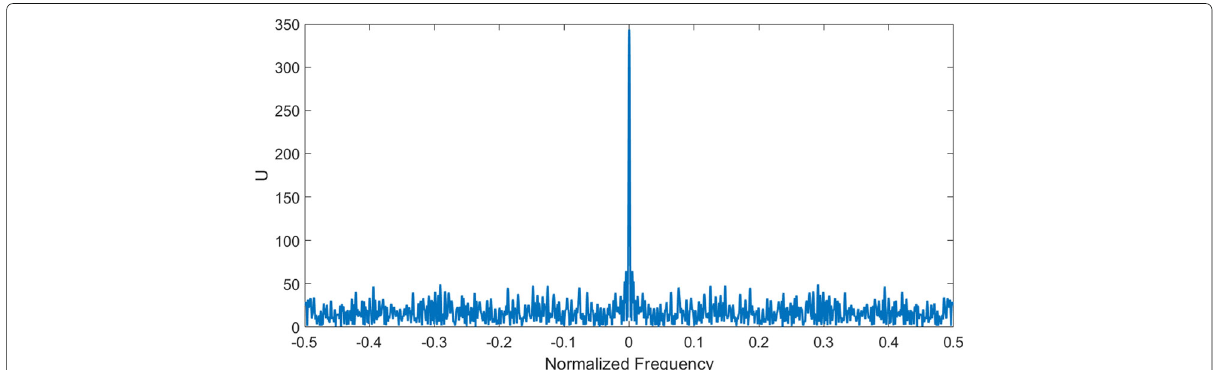
Fig. 4 4096 points DFT of u ( k ) after CS correction, burst length = 500 symbols, modulation type = BPSK, SNR = 10 dB. Constant timing delay is represented as DC component